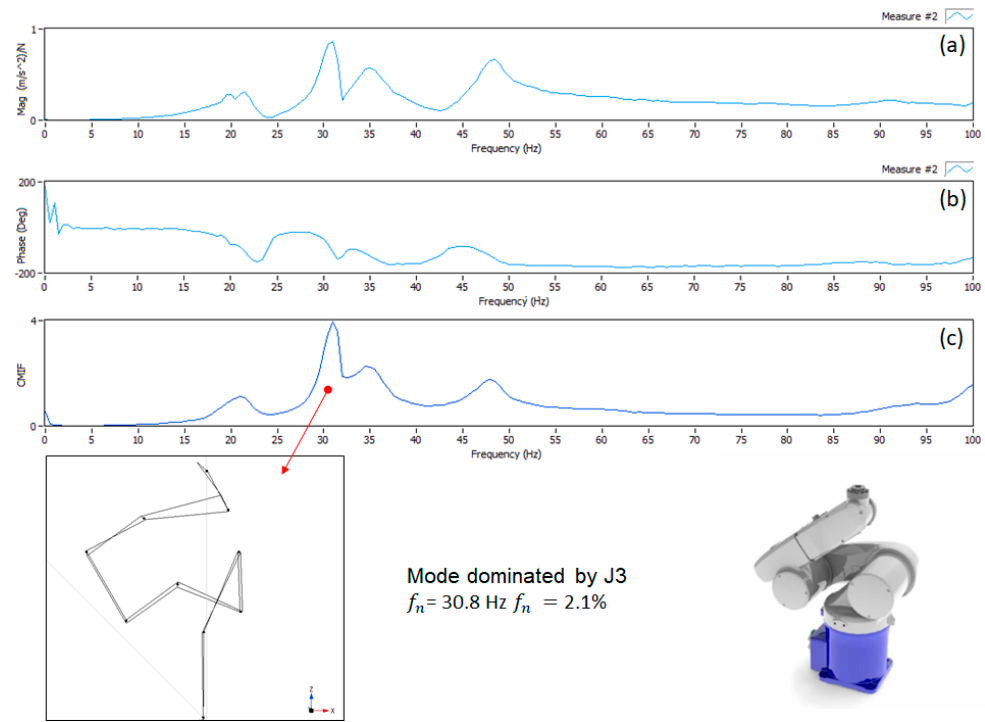
Figure 9. Test 3, ( a ) direct point frequency response function (FRF) modulus, ( b ) phase, ( c ) complex mode indicator function (CMIF).